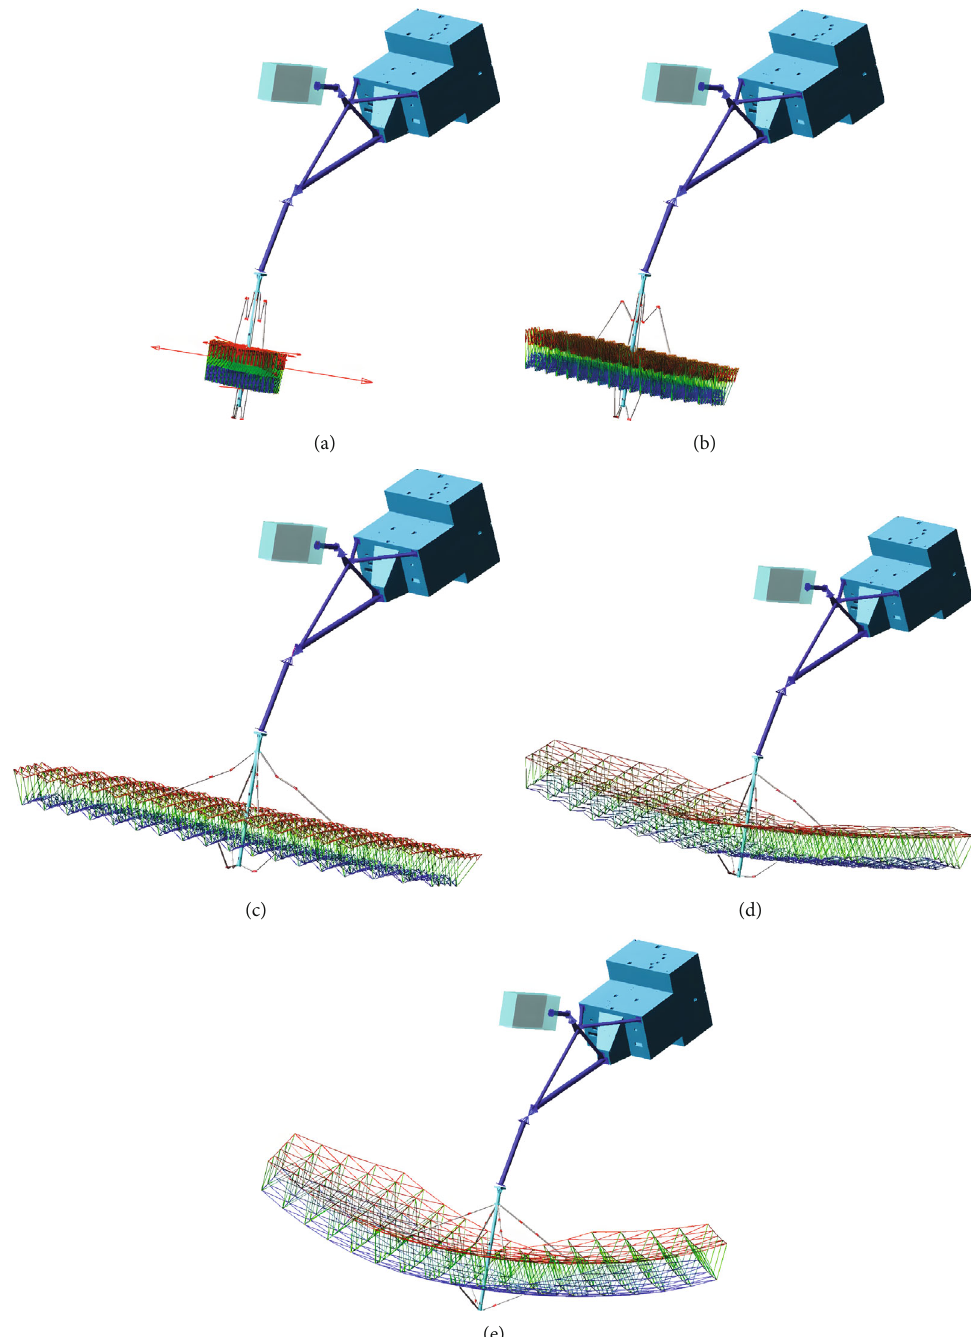
Figure 13: The deployment process of normal feed truss antenna satellite. (a) Deployed process 1. (b) Deployed process 2. (c) Deployed process 3. (d) Deployed process 4. (e) Deployed process